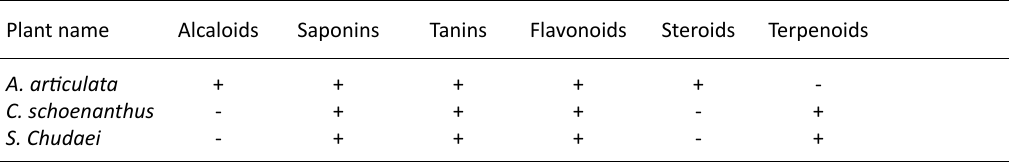
Table 2. Phytochemical screening of different plant powder homogenate Plant